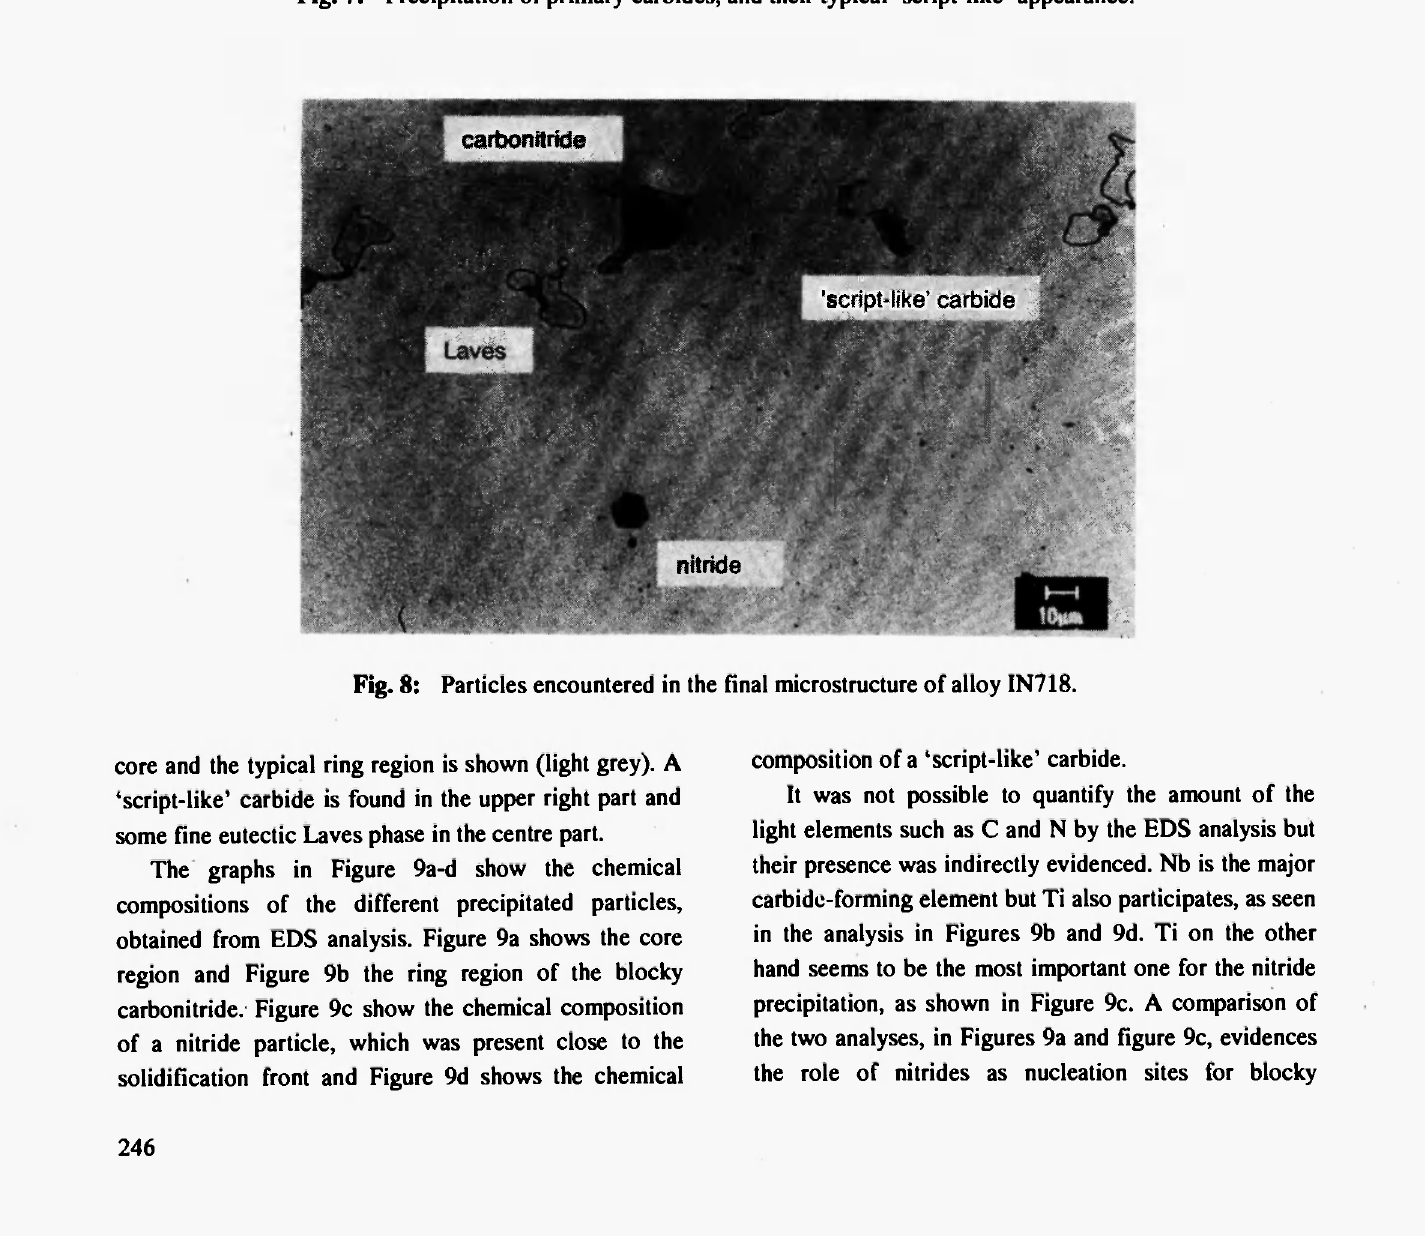
Fig. 7: Precipitation of primary carbides, and their typical 'script-like' appearance.